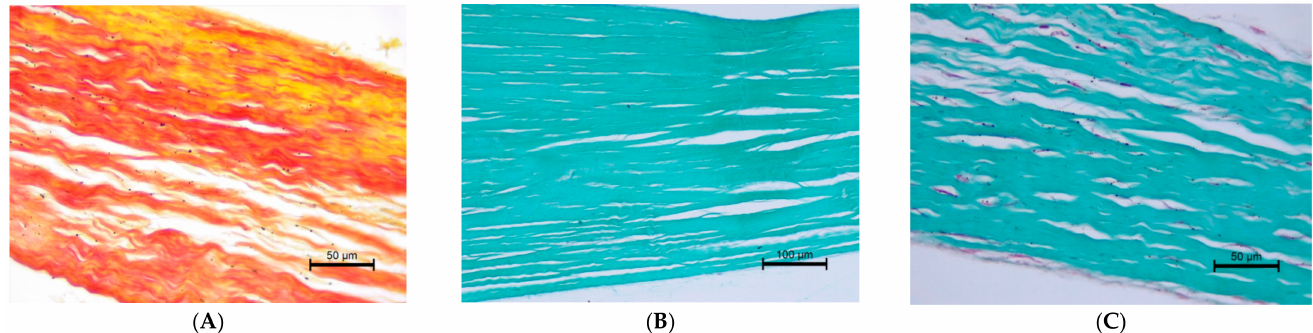
Figure 8. Ruptured Chordae tendineae . ( A ) elastic red–picrosirius stain; magnification 400 × . ( B ) (magnification 200 × ) and ( C ) (400 × ) Masson–Goldner trichrome stain. The valve part is at the left and papillary muscle part at the right of each